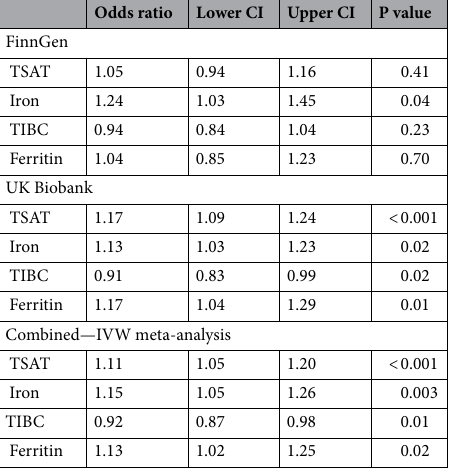
Table 2. Meta-analysed IVW MR estimates for each biomarker across both FinnGen and UK Biobank.